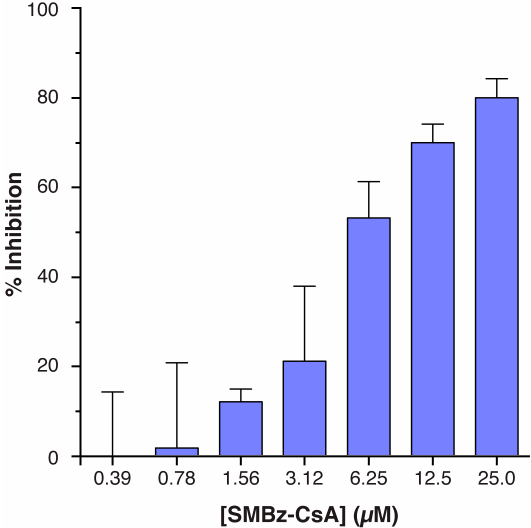
Figure 5. The non-immunosuppressive cyclosporine analogue SMBz-CsA inhibits HCVcc replication. Huh-7.5 cells were pretreated for 1 h at 37 °C with a serial dilution of SMBz-CsA, after which the cells were inoculated with J6/JFH HCVcc in duplicate. After 6 h the inoculum was removed and the cells re-fed with media without drug. The samples were fixed after 48 h, stained for viral antigen and nuclear DNA, and imaged using a plate reading microscope. The infection was then quantified using Infection Counter. The data is expressed as percentage of inhibition relative to Huh-7.5 cells treated with dimethyl sulfoxide (DMSO) control. Error bars indicate standard deviation from the mean, n = 3.